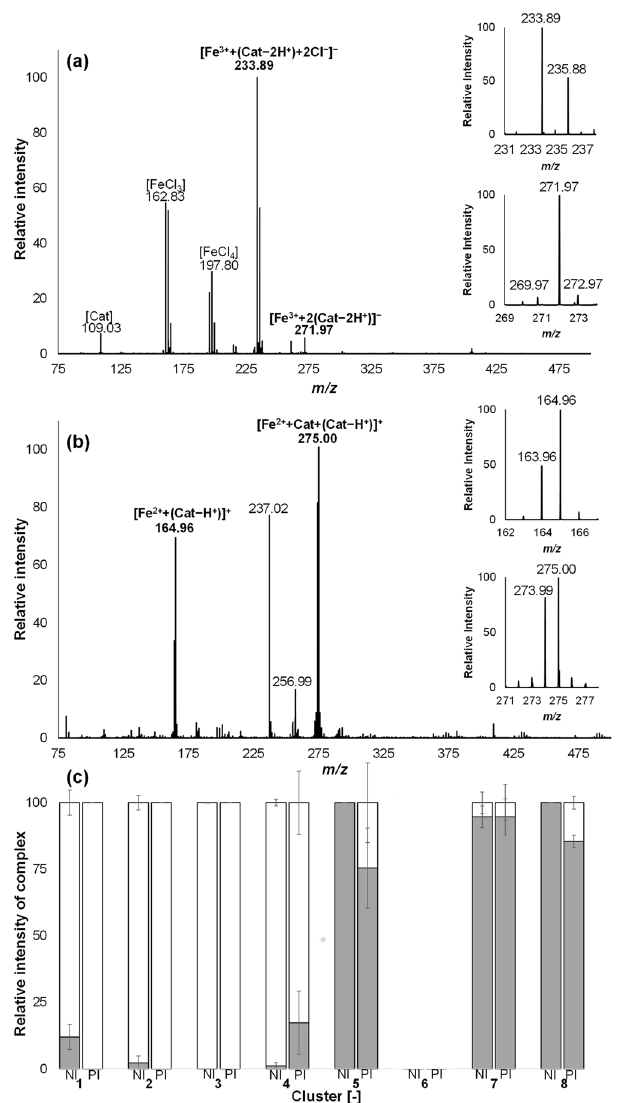
Figure 4. Electrospray ionisation mass spectra of a solution of ferric chloride (FeCl 3 ) and catechol, recorded in ( a ) negative (NI) and ( b ) positive (PI) ionisation mode. The insets represent the isotopic patterns of the monocatecholate and dicatecholate complexes. ( c ) Relative intensities of monocatecholate (grey) and dicatecholate (white) iron complexes in each of the hierarchical clusters (Fig. 3) as measured in negative (NI) and positive (PI) ionisation mode (n = 3, error bar is relative standard deviation). For cluster 6 only traces of complex/or no complex at all was observed in the mass